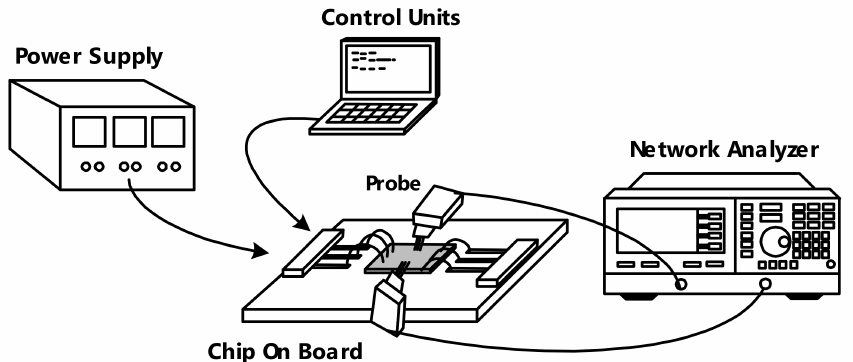
Figure 8. Microphotograph of the Ku-band CMOS transmit and receive IC.